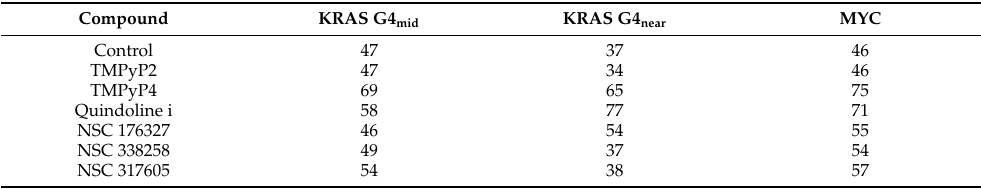
Figure 1. Identification of NSC 317605 as a selective stabilizer of KRAS G4 mid . ( A ) Six compounds were examined by ( B ) FRET Melt for stabilization of the KRAS mid, KRAS near and MYC G4–forming sequences (color-coded compound names match the data in the FRET Melt graphs). The negative (TMPyP2) and positive (TMPyP4) compounds performed appropriately. Quindoline i stabilized all sequences, whereas NSC 338258 stabilized only the MYC G4. NSC 176327 stabilized the KRAS G4 near and MYC sequences, whereas NSC 317605 stabilized the KRAS G4 mid and MYC sequences. ( C ) The lead potential G4-stabilizing compound was studied in cellular systems for changes in promoter activity by luciferase ( top ), cytotoxicity ( middle ) and correlated transcriptional changes ( bottom ). * p < 0.05, as compared to control, by one-way ANOVA. Experiments were performed minimally in duplicate with internal replicates (duplicates or triplicates for FRET Melt and cytotoxicity, respectively). Table 2. Thermal FRET melt ( ◦ C) of G4 structures without and with